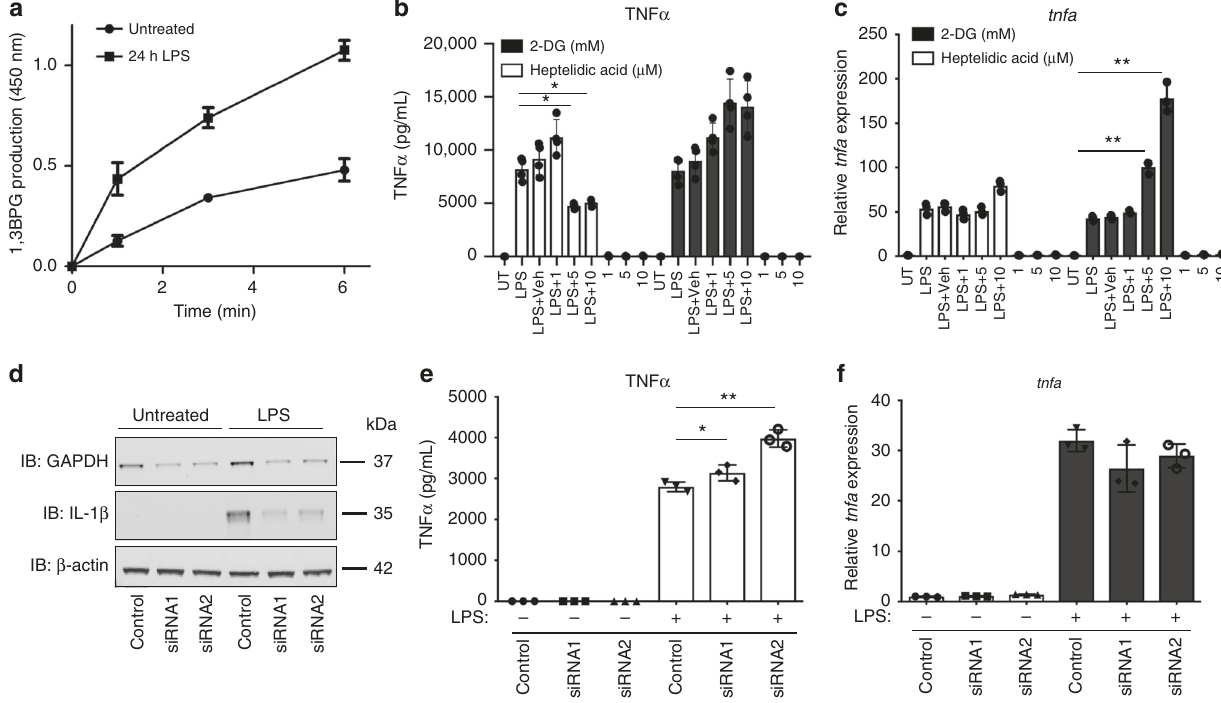
Fig. 3 GAPDH controls TNF α production. a Untreated, 6 and 24 h LPS-treated (100 ng/mL) BMDM lysates were assayed for GAPDH enzymatic activity by monitoring product production (1,3 bisphosphoglycerate, 1,3BPG) over time. Representative of three independent experiments. b TNF α protein measured by MSD (mean + SEM, n = 4) and c TNF α mRNA expression in 100 ng/mL LPS-treated BMDMs (6 h), pre-treated with HA or 2-DG. d GAPDH siRNA (72 h, 10 nM) KD in BMDMs, measured by western blotting. Pro-IL1 β levels were also measured, and β -actin used as a control. Representative of three independent experiments. e TNF α measured in GAPDH KD BMDMs, treated with LPS (24 h, 100 ng/mL, mean + SEM, n = 3). f TNF α mRNA expression measured by qPCR in LPS-treated GAPDH KD BMDMs. Unpaired t -test, * p < 0.05; ** p < 0.01 NATURE COMMUNICATIONS| (2019) 10:338